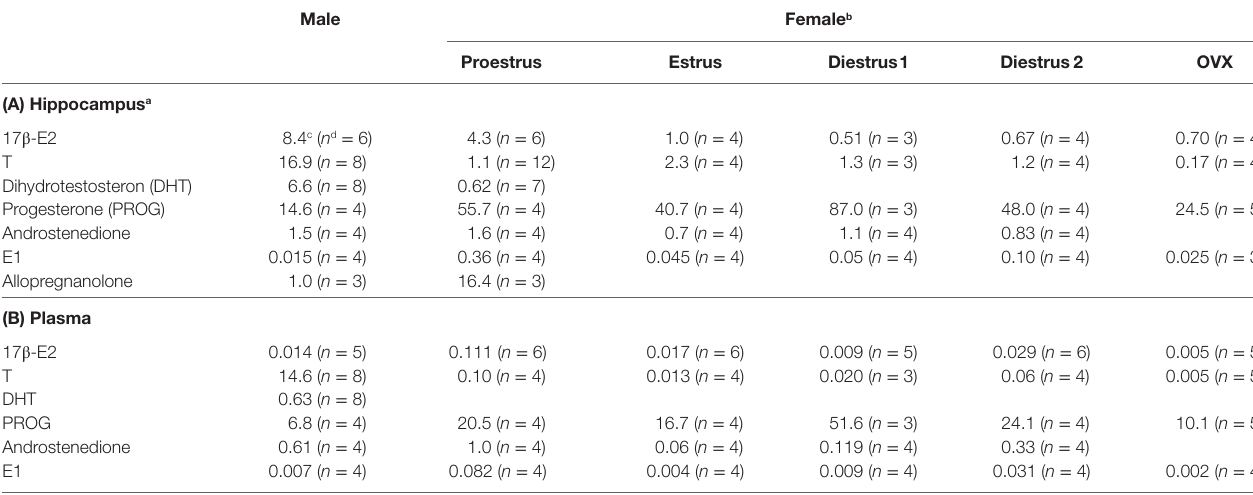
TABle 1 | Mass spectrometric analysis of the concentration of steroids in the hippocampus and plasma of adult